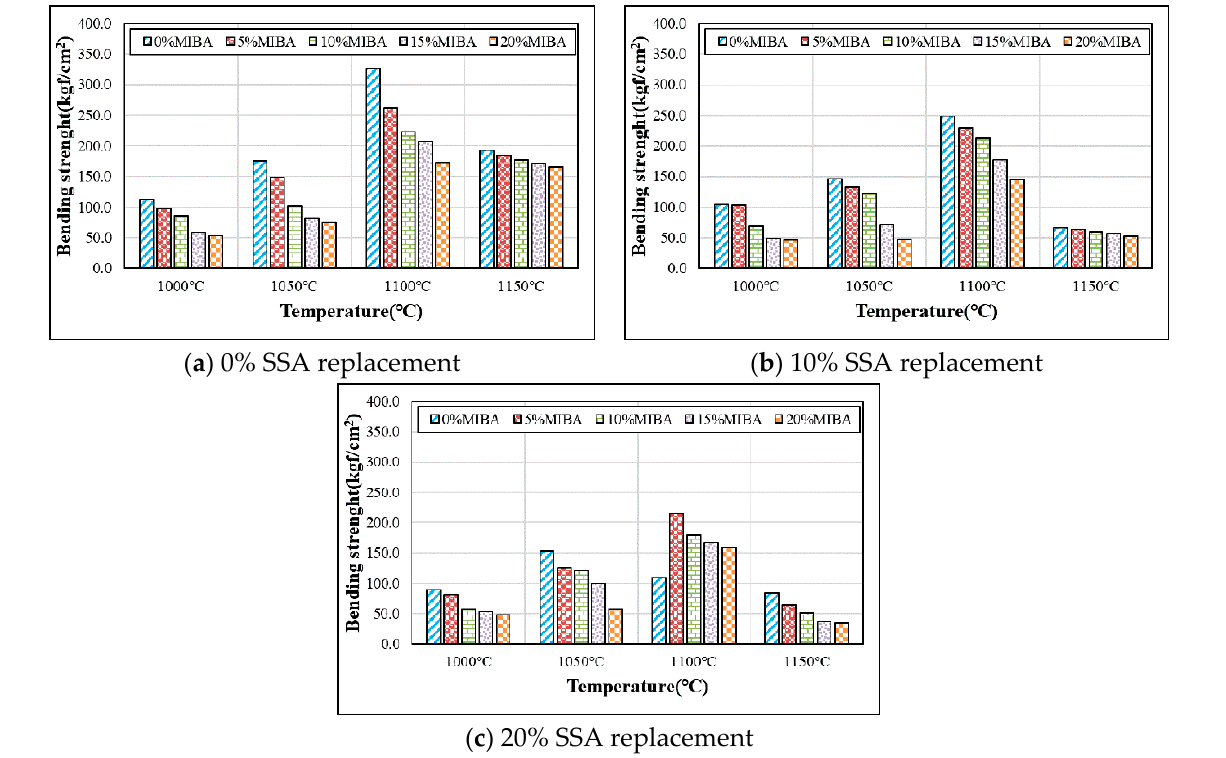
Figure 8. Results of the bending strength tests. ( a ) 0% SSA; ( b ) 10% SSA; ( c ) 20% SSA.